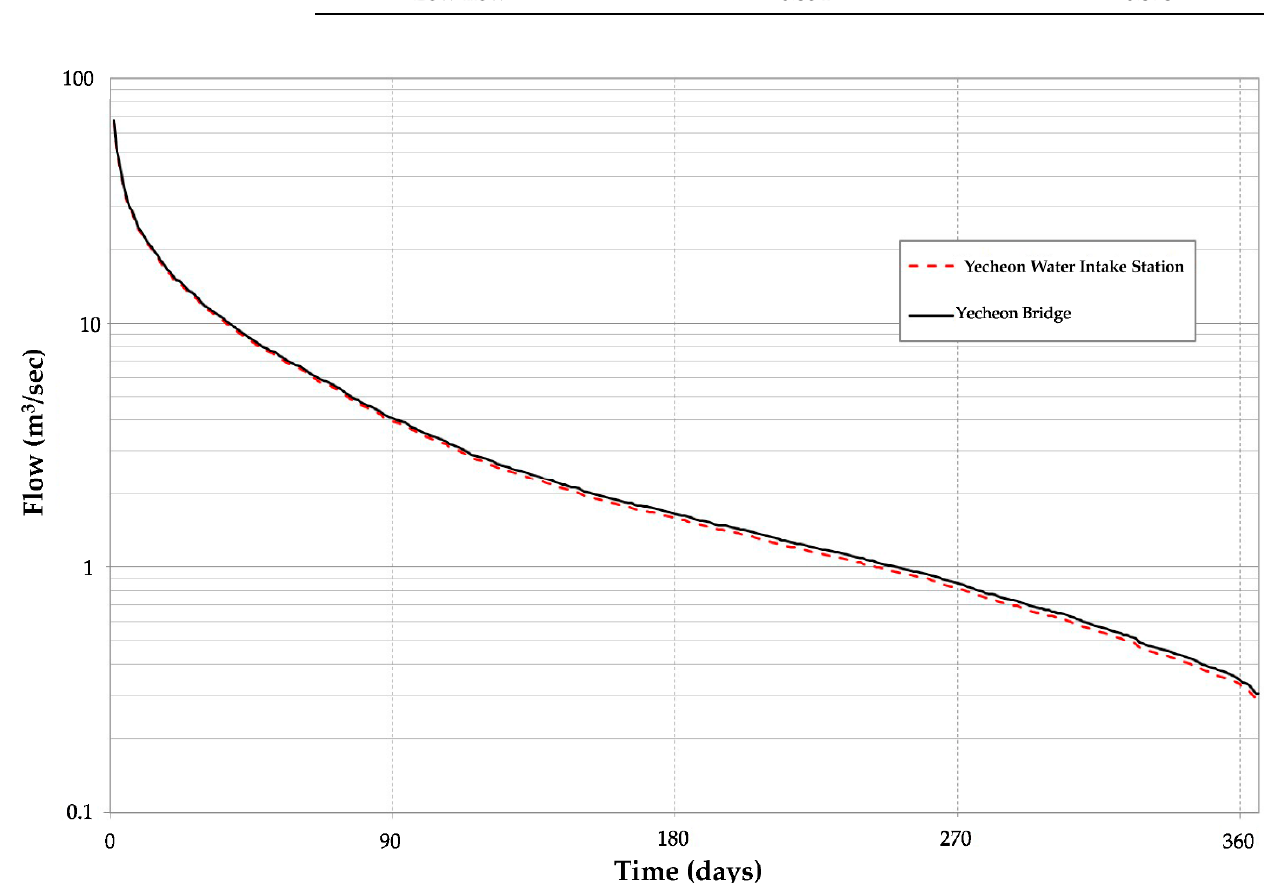
Figure 10. Comparison of flow-duration curves for Yecheon Water Intake Station and Yecheon Bridge (flood control of- fice).